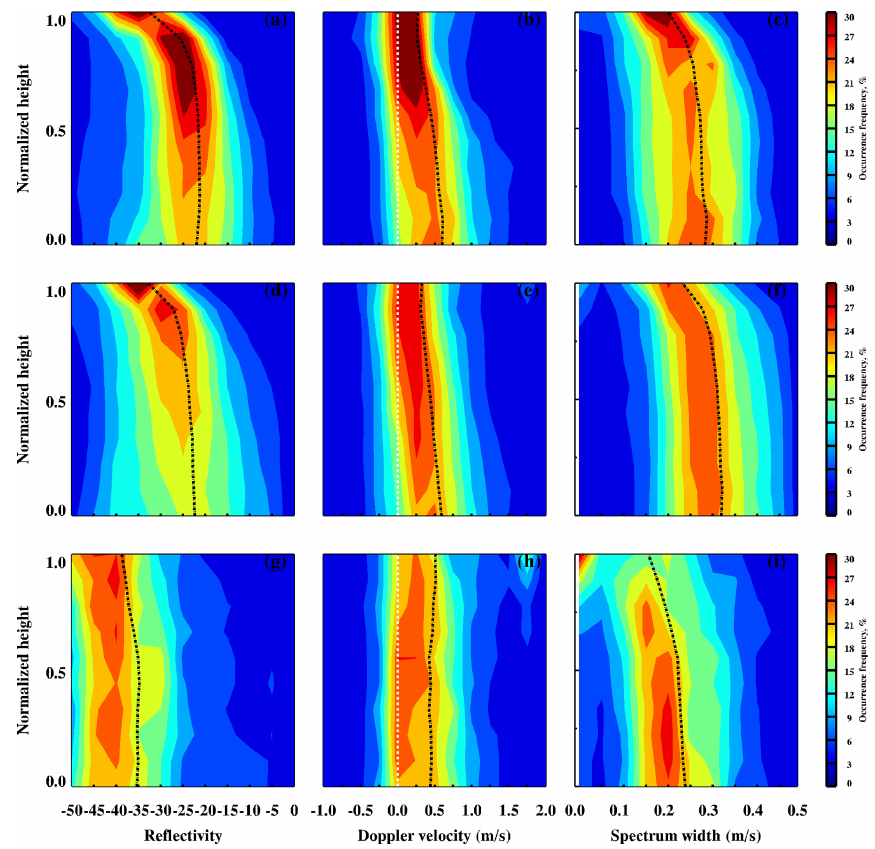
Figure 11. Normalized vertical distributions of radar reflectivity (a) , Doppler velocity (b) , and spectrum width (c) for the classified liquid (a–c) , mixed-phase (d–f) , and ice (g–i) clouds over the north of 60 ◦ S during the MARCUS intensive observational period (IOP). Normalized − H base height is defined as = H , where the cloud base is denoted as 0 and cloud top is 1. The black lines represent the median values, and H top − H base the white lines in Doppler velocity represent the reference of 0.0ms − 1 .